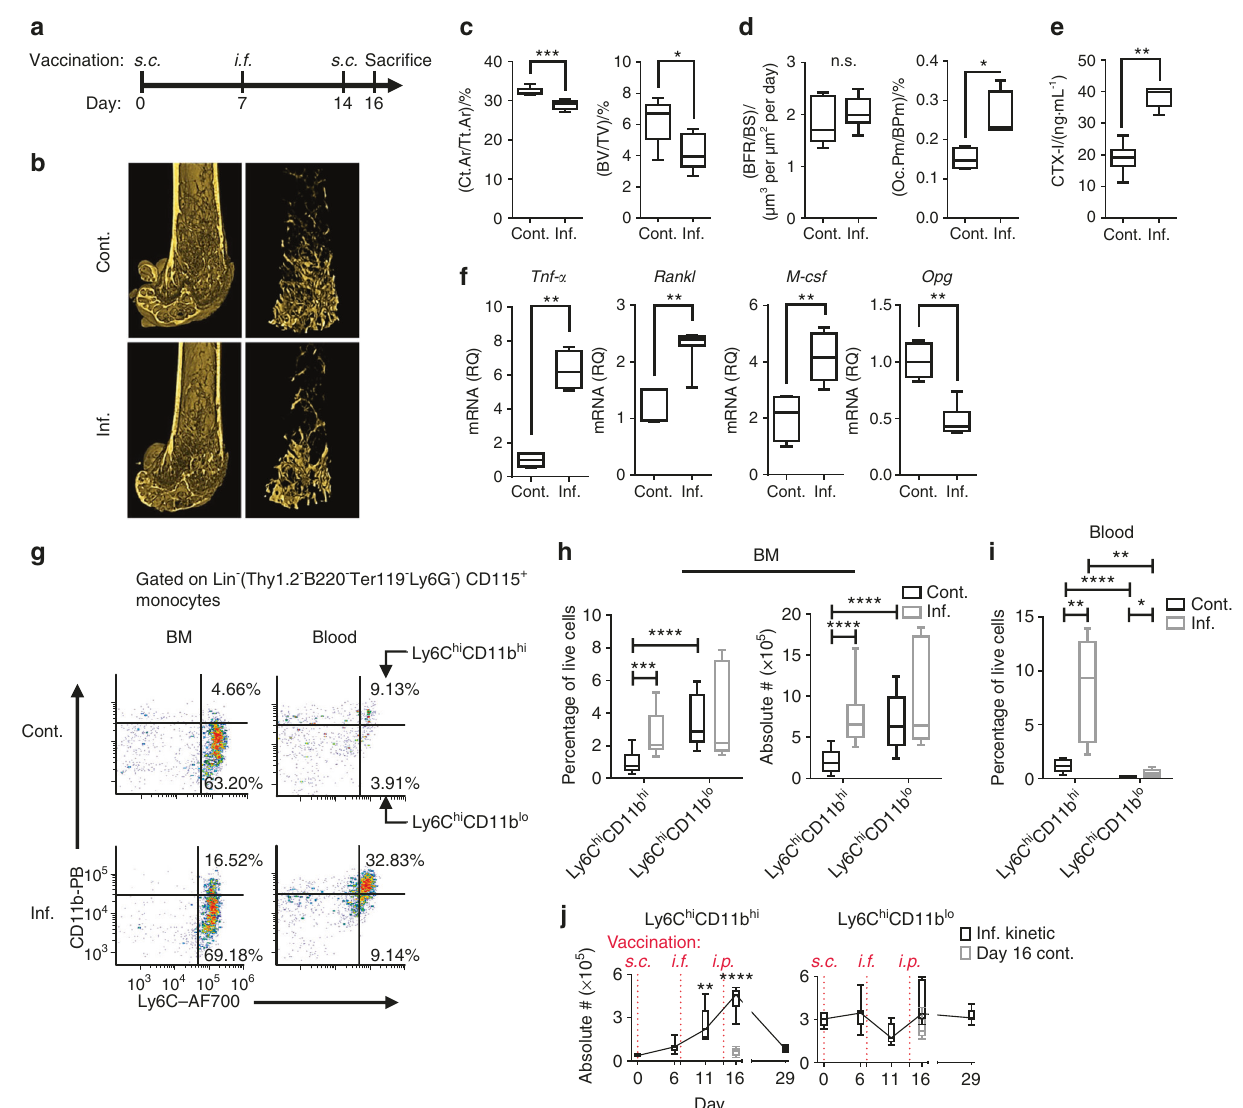
Fig. 1 Chronic in fl ammation augments OC activity and expands Ly6Chi monocyte populations. a Time course of the vaccination model (see the Methods section for details). b Representative 3D modeling from femoral microCT scans of control (cont.) and in fl amed (inf.) mice. All microCT scans were performed on the right femur. c MicroCT evaluation of the cortical bone cross-sectional area fraction (Ct.Ar/Tt.Ar) and trabecular bone volume/total volume (BV/TV). d Histomorphometric indices: bone formation rate/bone surface (BFR/BS) and fraction of OCs occupying the cortical perimeter (Oc.Pm/BPm). The full microCT and histomorphometric results are shown in Table S1. e Serum collagen type 1 cross-linked C-telopeptide (CTX-I) levels. f Relative quantities (RQs) of Tnf- α , Rankl , M-csf and Opg transcripts in RNA extracted from the proximal half of the right tibia. a – f Control n = 7, in fl amed n = 7; representative results for three independent experiments (Mann – Whitney test and Holm multiplicity correction). g Flow cytometric analysis of leukocytes isolated from the BM and blood of control and in fl amed mice. The plots are gated on Lin - (Thy1 . 2 - B220 - Ter119 - Ly6G - )CD115 + monocytes and depict the Ly6C hi CD11b hi and Ly6C hi CD11b lo subsets. h Ly6C hi CD11b hi and Ly6C hi CD11b lo cell frequencies and absolute numbers in the BM of control and in fl amed mice [absolute number in BM extracted from 1 leg (femur + tibia)]. i Frequency in the blood. Representative results for three independent experiments are presented. Control n = 15, in fl amed n = 15 (Mann – Whitney test and Holm multiplicity correction). j Kinetics of Ly6C hi CD11b hi and Ly6C hi CD11b lo cell accumulation in the BM during the vaccination protocol. In fl amed n = 7 for each time point, Day 16 control n = 6 (Kruskal – Wallis and Dunn post-test all compared to Day 0). Line: median, box: 25 th – 75 th percentile, whiskers: range. * P < 0.05, ** P < 0.01, *** P < 0.00 1, **** P < 0.000 1. ( s.c . – subcutaneous, i.f . – intrafootpad, i.p . – upon monocyte isolation (Fig. S4b), which was performed prior to demonstrate that Ly6C hi CD11b hi OCPs possess stronger migratory sorting in all the following ex vivo experiments. Together, these capabilities than Ly6C hi CD11b lo OCPs. markers exclude both populations from early multipotent We next screened the two subpopulations for the expression of progenitors (Lin - Sca1 + CD117 + ), common DC progenitor popula- known OCP surface markers. Fractions of both Ly6C hi CD11b hi and Ly6C hi CD11b lo BM populations were Sca1 lo in in fl amed mice, but tions (FLT3 + ) 23 and cMoPs (Ly6C hi CD11b lo CD117 + ) 18 . Both popu- all cells were negative in controls (Fig. S4a, left). Both populations lations were CD11c - (Fig. S4c, left), distinguishing them from BM DC populations, which reportedly differentiate into OCs 24,25 . were negative for FLT3 (Fig. S4a, left and middle), and most were CD117 - (Fig. S4a, right). The small CD117 + fraction was depleted Both populations exhibited low F4/80 expression compared to